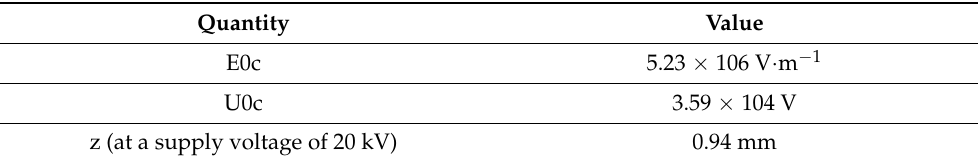
Table 2. The initial critical intensity of the electric field, the initial critical voltage, and the radius of the ionization zone.